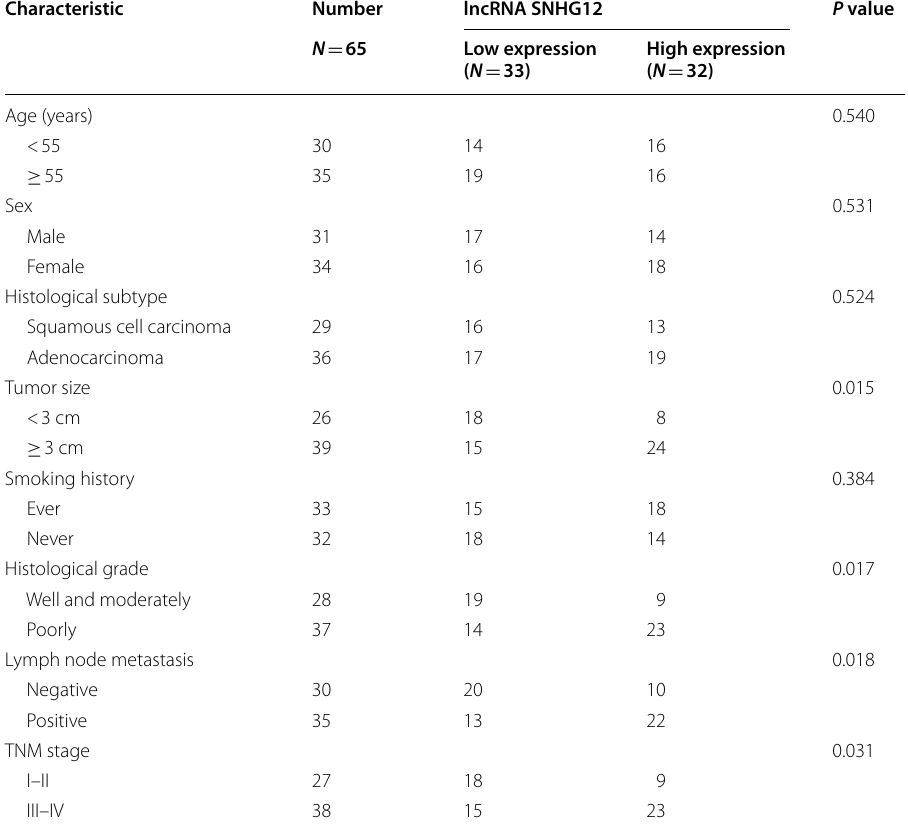
Table 2 Correlation between lncRNA SNHG12 and clinicopathological characteristics of patients with